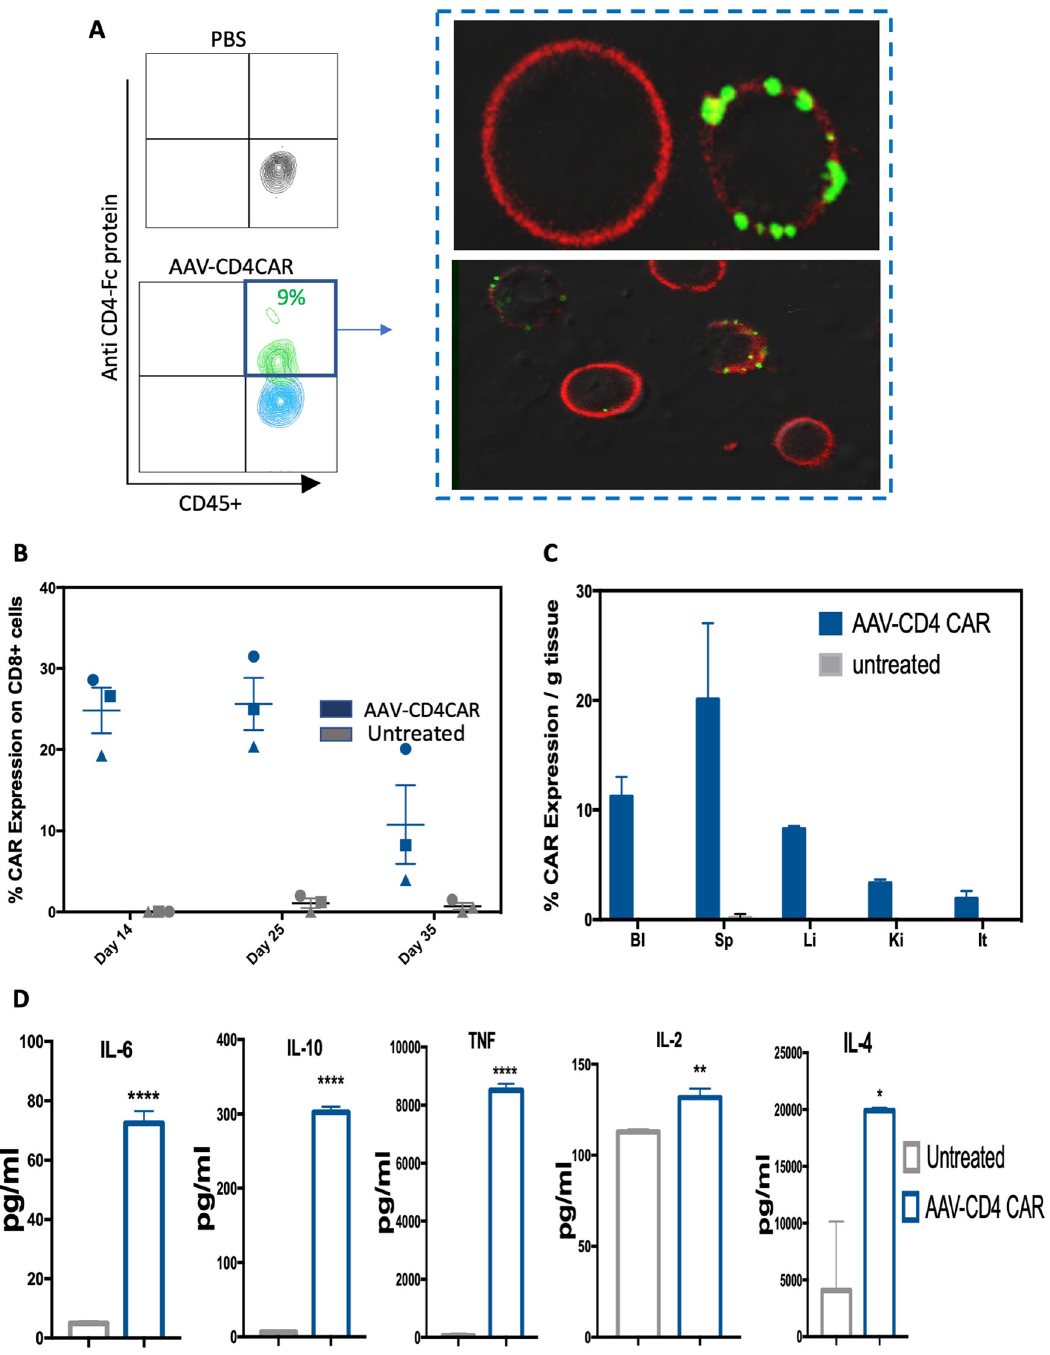
Fig. 3 AAV-CD4CAR reprograms immune cells and generates in vivo tumor-speci fi c AAV-CD4CAR T cells. A Representative fl ow cytometry results showing the expression of AAV-CD4CAR on CD45 + cells 48 h after infusing a single dose of 1 × 10 11 AAV-CD4CAR into NCG-HuPBL mice ( n = 3). The right panel shows the confocal imaging of CD45 + cells expressing AAV-CD4CAR expression. The red shows the cellular membrane, whereas the green dots represent AAV-CD4CAR expression on the cell. B A total of 1 × 10 11 AAVs carrying the CD4CAR gene were injected into mice ( n = 3), and AAV-CD4CAR expression was demonstrated by FACS at the indicated time. Distinct symbols represent different donor PBMCs used for the development of the HuNCG mouse model. All data are shown as the mean ± s.e.m. with error bars on the graph. C Graphical representation of the biodistribution of AAV-CD4CAR T cells in various tissues ( n = 3). Bl blood, Sp spleen, Li liver, Lu lung, It intestine, Ki kidney. Cells isolated from the spleen, liver, kidney, blood, and intestine were analyzed by fl ow cytometry for AAV-CD4CAR expression on CD8 + cells. All data are shown as the mean ± s.e.m. with error bars on the graph. D Graphical representation of different cytokines detected in the plasma of tumor-bearing ATL NCG-HuPBL mice ( n = 3), at 2 weeks after AAV injection. Cytokines were detected through FACS by using the BD Cytometric Beads Array Human Th1/Th2 Cytokine Kit. An unpaired two-tailed t -test was used for analysis. ns, no signi fi cance; **** P < 0.0001. *** P < 0.001; ** P < 0.01; * P <